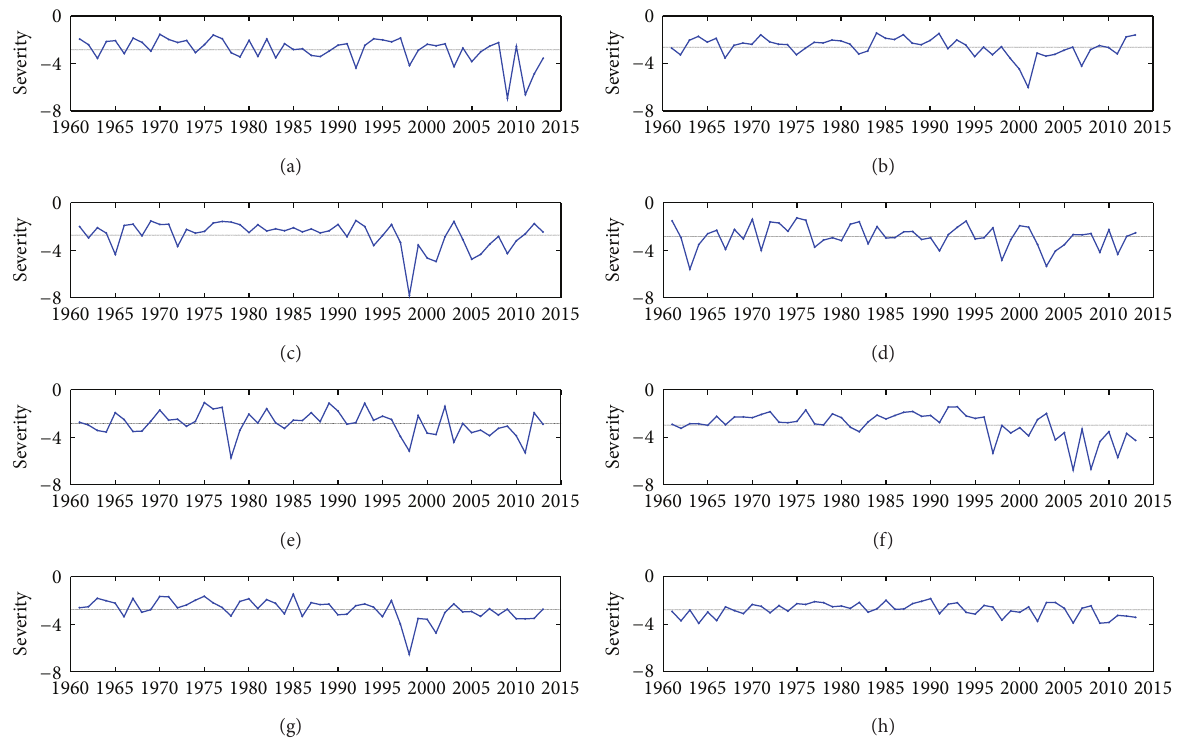
Figure 6: Temporal variation of drought severity in eight regions: (a) SW; (b) NE; (c) N; (d) SE; (e) YR; (f) NW; (g) C; (h)